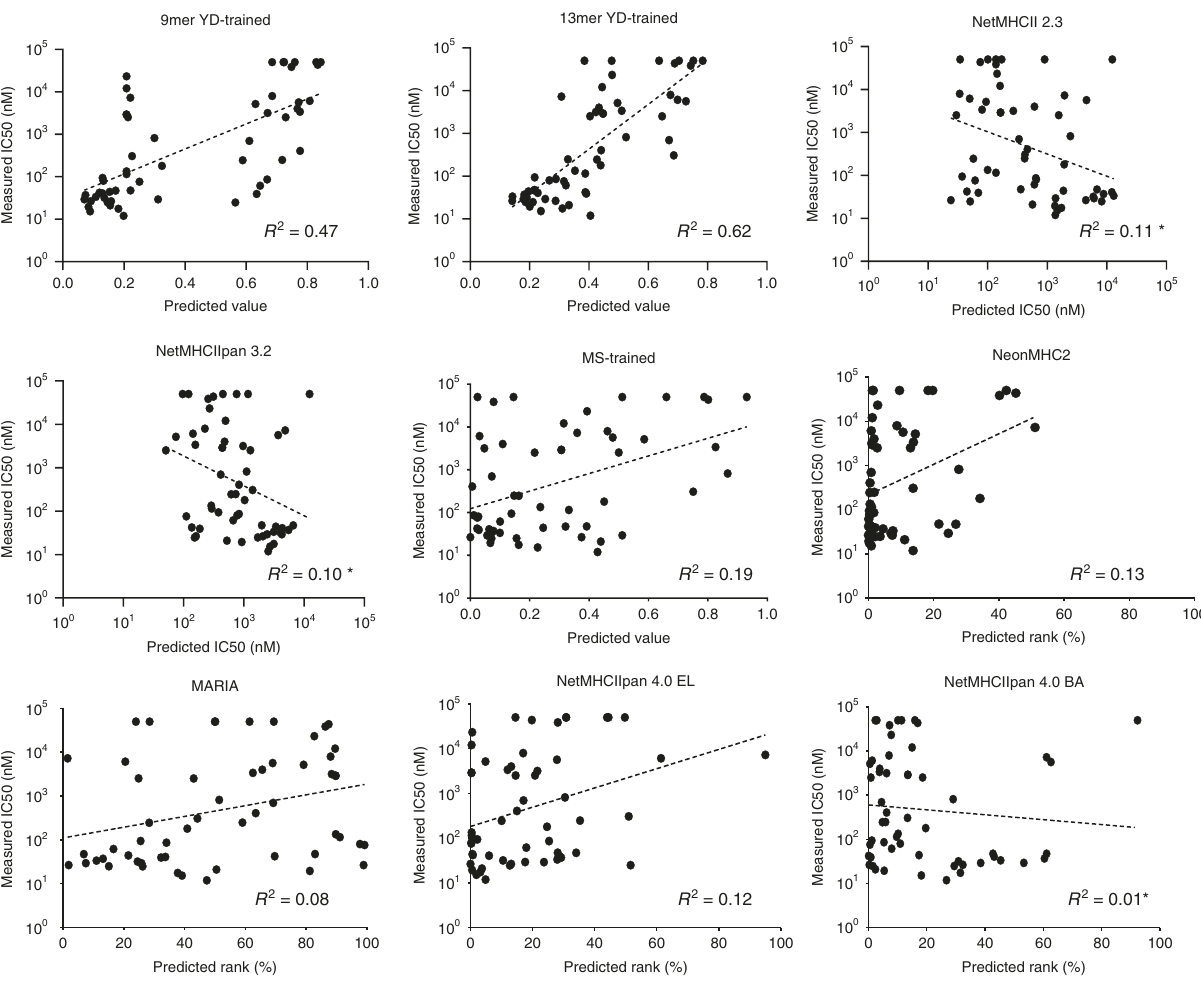
Fig. 7 Benchmarking MHC-II algorithm performance for prediction of peptide-binding af fi nity. Scatterplots of algorithmic predictions versus measured IC 50 values for 55 peptides assayed for binding to HLA-DR401 in fl uorescence polarization competition assays, with lines of best fi t and their associated coef fi cients of determination ( R 2 ). Asterisk denotes R 2 values of negative correlations. Source data are provided as a Source Data fi